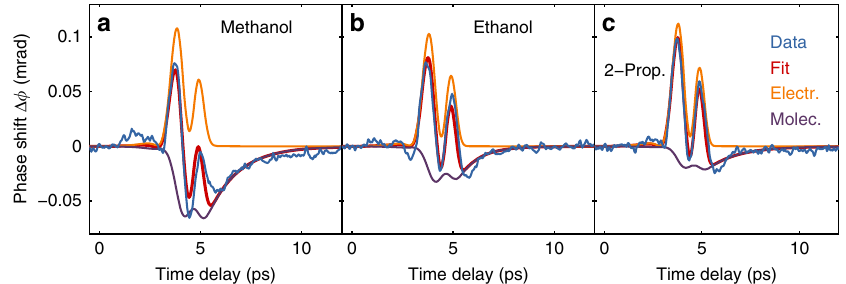
Fig. 3 The THz-induced Kerr effect in alcohols: a methanol, b ethanol, and c 2-propanol. The color code corresponds to the one in Fig. 1. While all alcohols also reveal a negative polarizability anisotropy, they also show a THz-induced electronic response, which clearly dominates, e.g., in